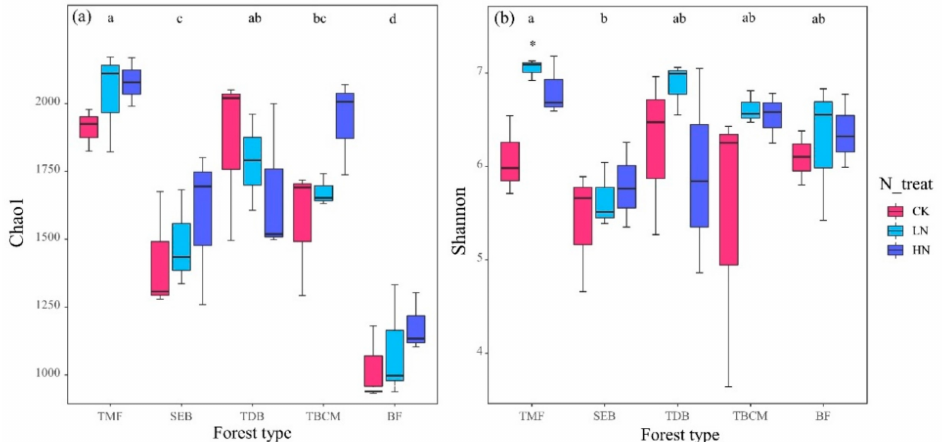
Figure 1. Soil fungal Chao1 index ( a ) and Shannon index ( b ) under N additions in different forest types. Values sharing the same letter are not significantly different among forest types ( p > 0.05). The stars indicate significant differences in fungal diversity in comparison to the control at p < 0.05. TMF: tropical montane rain forest, SEB: subtropical evergreen broadleaved forest, TDB: temperate decidu- ous broadleaved forest, TBCM: temperate broadleaved and conifer mixed forest, BF: boreal forest.